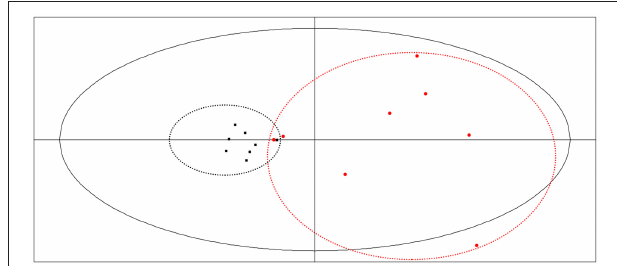
FIGURE 6 | PCA plot of microcalorimetry parameters generated using Simca-P software. Samples of LJF appear as black points, while samples of LF appear as red points.